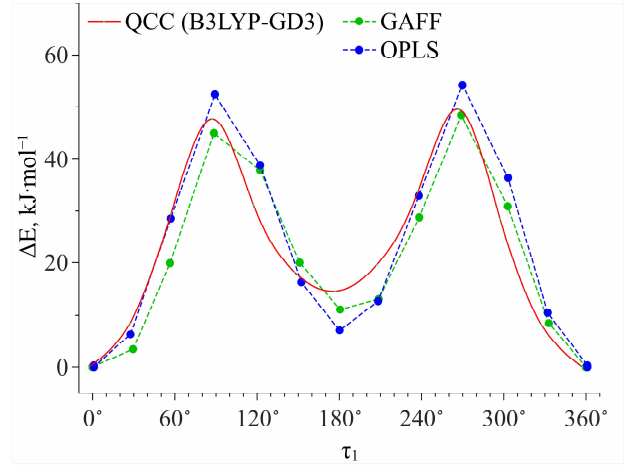
Figure 6. Comparison of the potential energy profiles along the dihedral angle τ 1 obtained within QCC using the B3LYP–GD3 functional and those obtained with the GAFF and OPLS force fields.